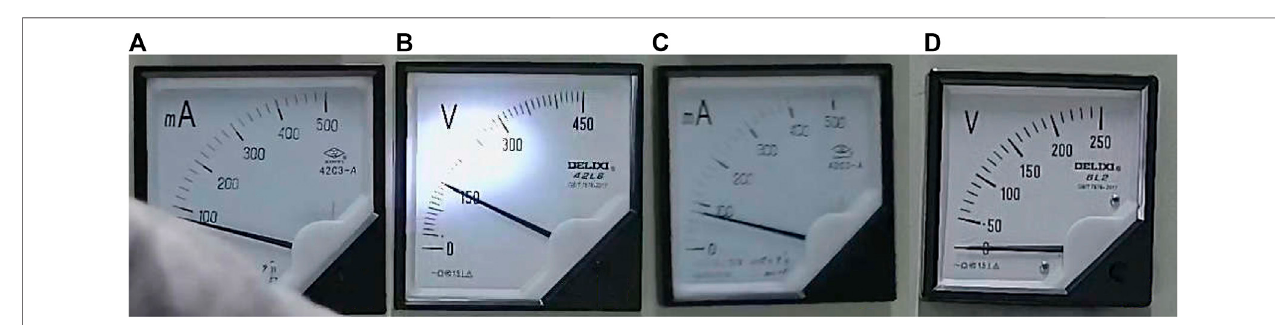
FIGURE7| Thesituation ofinaccurate identi fi cation results. (A) Itcanonlyidentifythescaleintheclockwisedirection,andtheidenti fi cation resultofthescalevalue was unstable, while the contrary was the case in (B) , (C) was fuzzy, only the pointer can be identi fi ed, and the scale and scale value cannot be identi fi ed. (D) Because of the uneven dial scale values, special treatment was